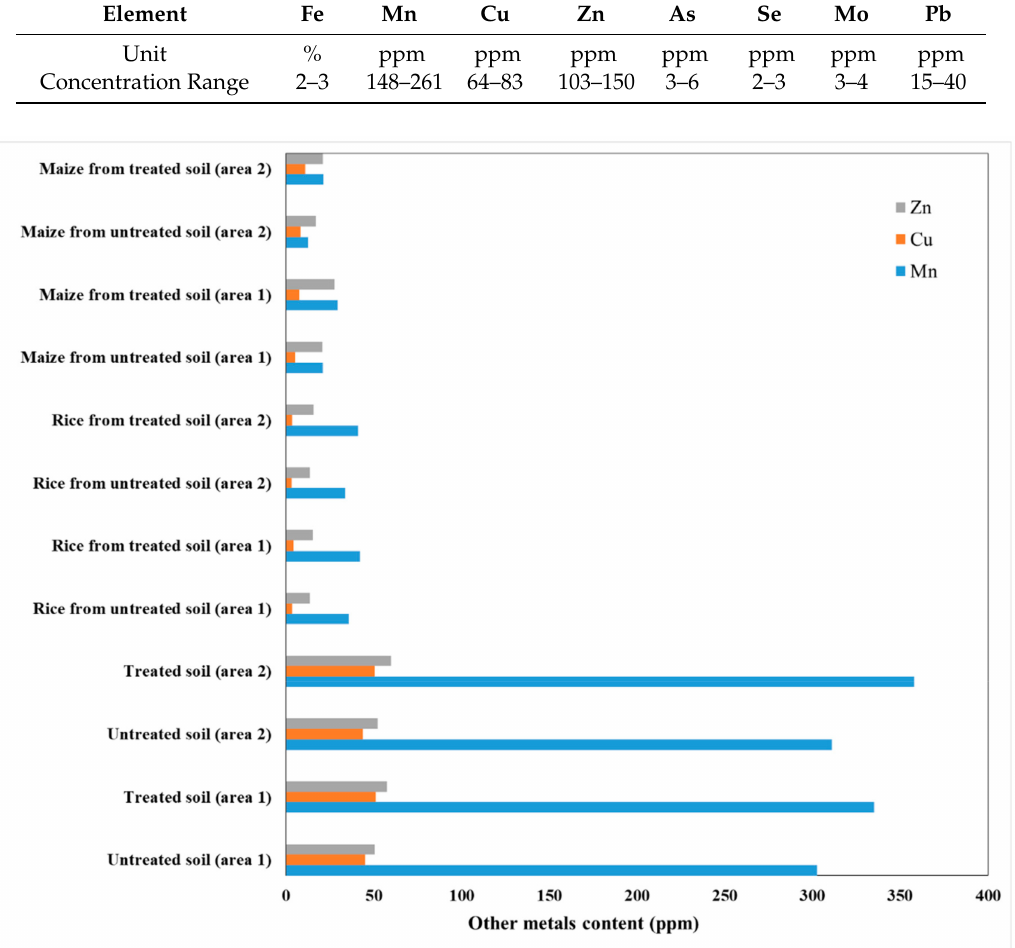
Figure 5. Heavy metal contents in soil, rice and maize from two areas, treated and untreated with fly